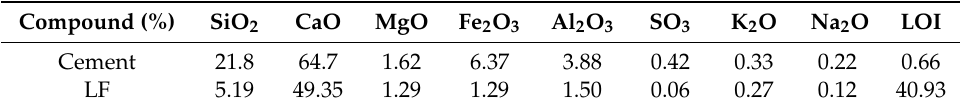
Table 1. Chemical composition of cement and limestone filler (LF).